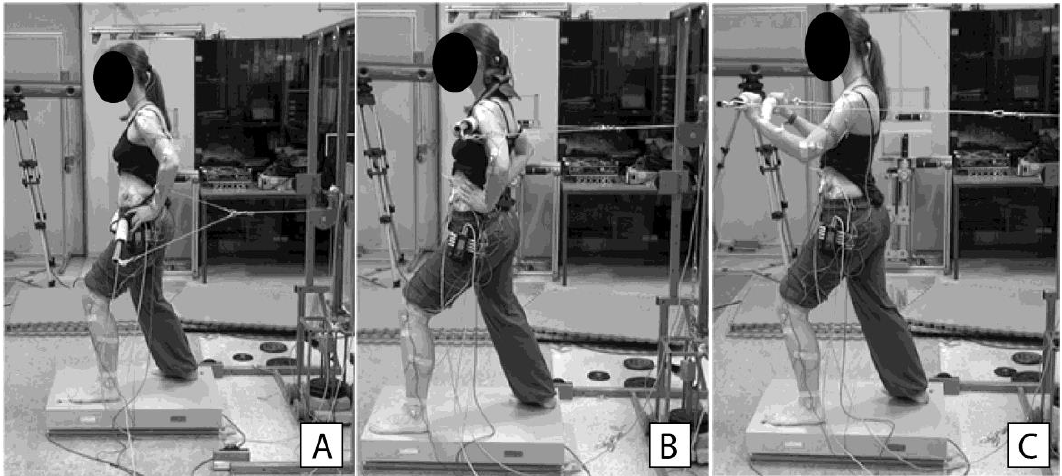
Figure 1. Experimental setup. The padded pole to load the participant’s body at the height of the hips ( A ), shoulders ( B ) and through the arms ( C